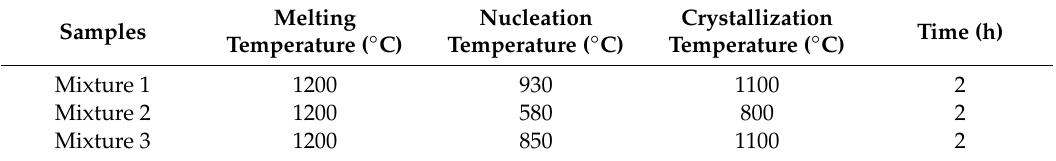
Table 3. Content temperatures for sintering treatments according to the DTA results.